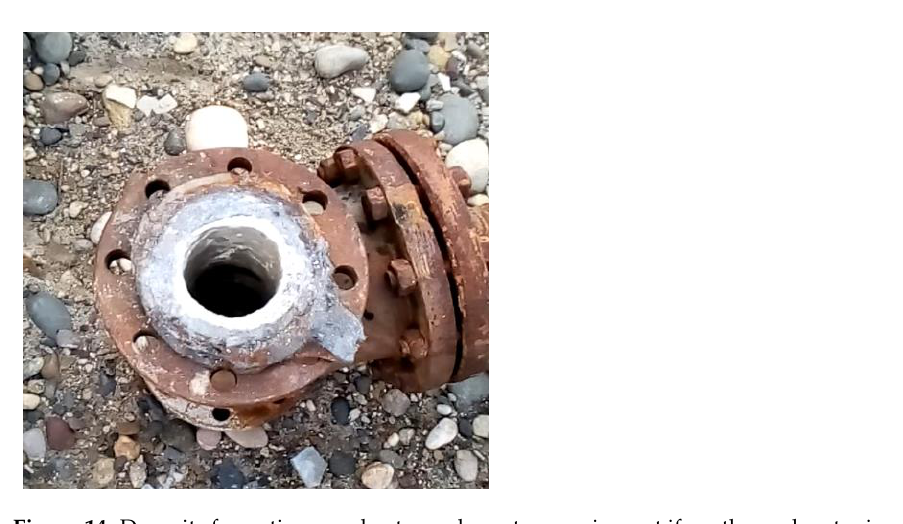
Figure 14. Deposits formation on a heat supply system equipment if geothermal water is not treated with an acoustic–magnetic device. with an acoustic–magnetic